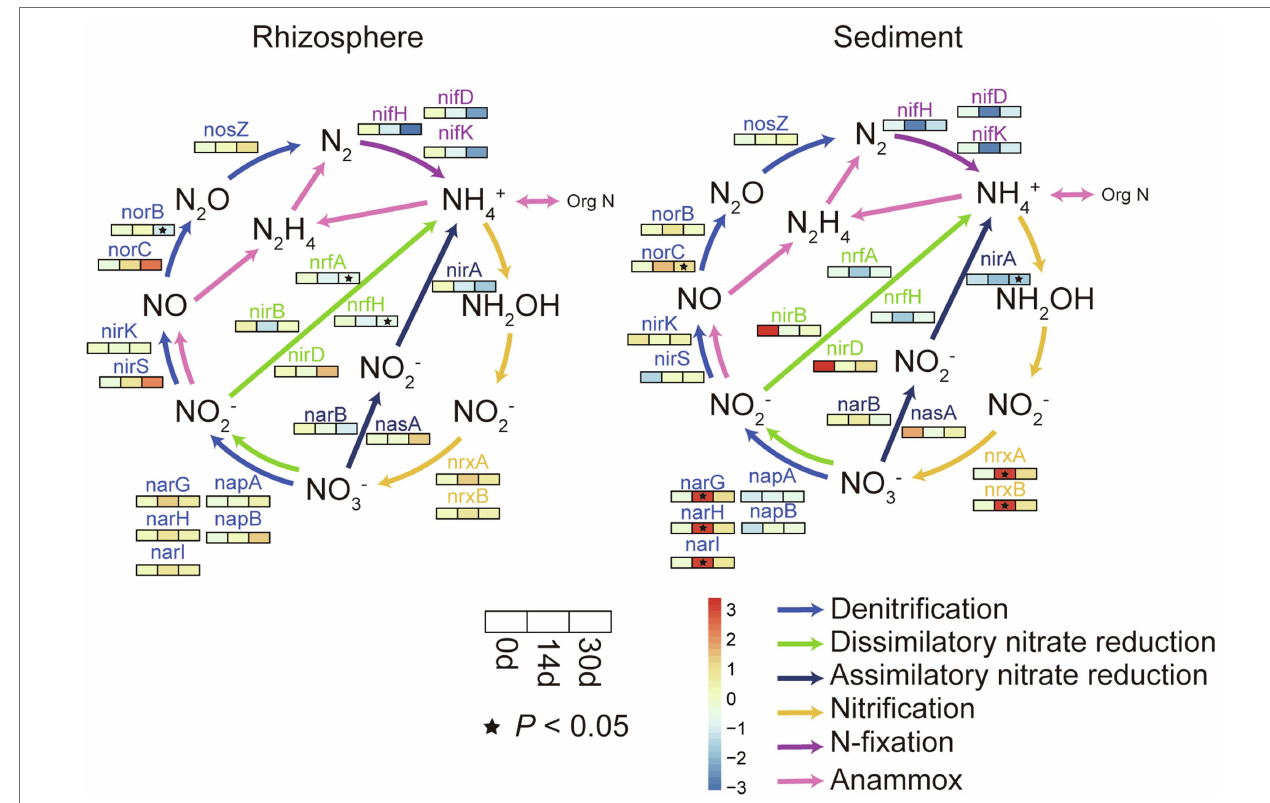
FIGURE 3 | Relative changes of N-cycling genes in rhizosphere and sediment. For each subfigure, the value represented by the color was calculated by Welch’s t test in STAMP, colors indicate relative differences in gene abundance between the biochar addition groups and control groups, value >0 (red) means biochar addition group has a higher abundance, while value <0 (blue) means control group has a higher abundance. (* p <